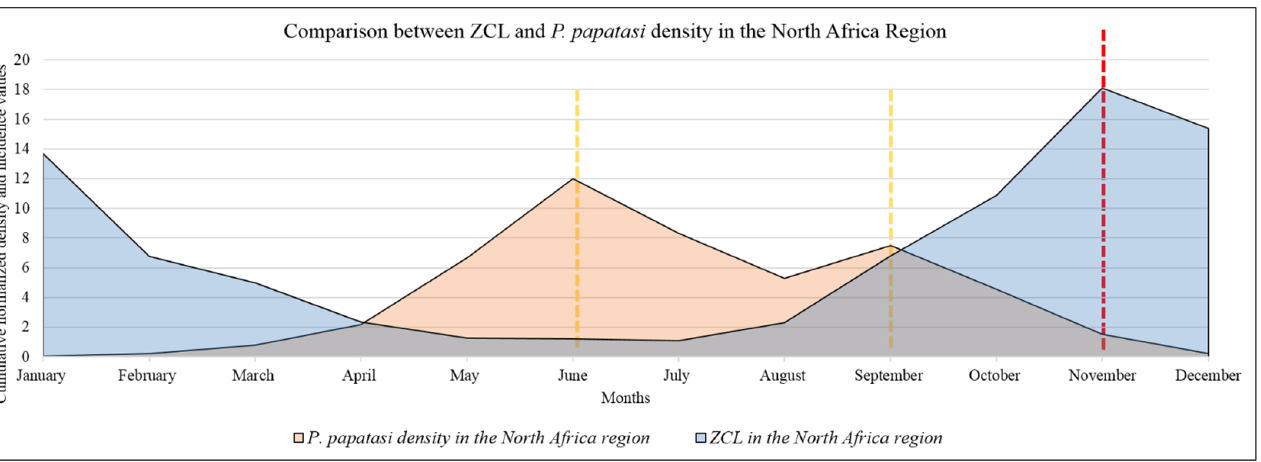
Figure 7. Seasonality in ZCL case number and P. papatasi density at the North African scale. Yellow dotted lines refer to the peaks of P. papatasi density and red dotted line indicates the peak of ZCL cases.